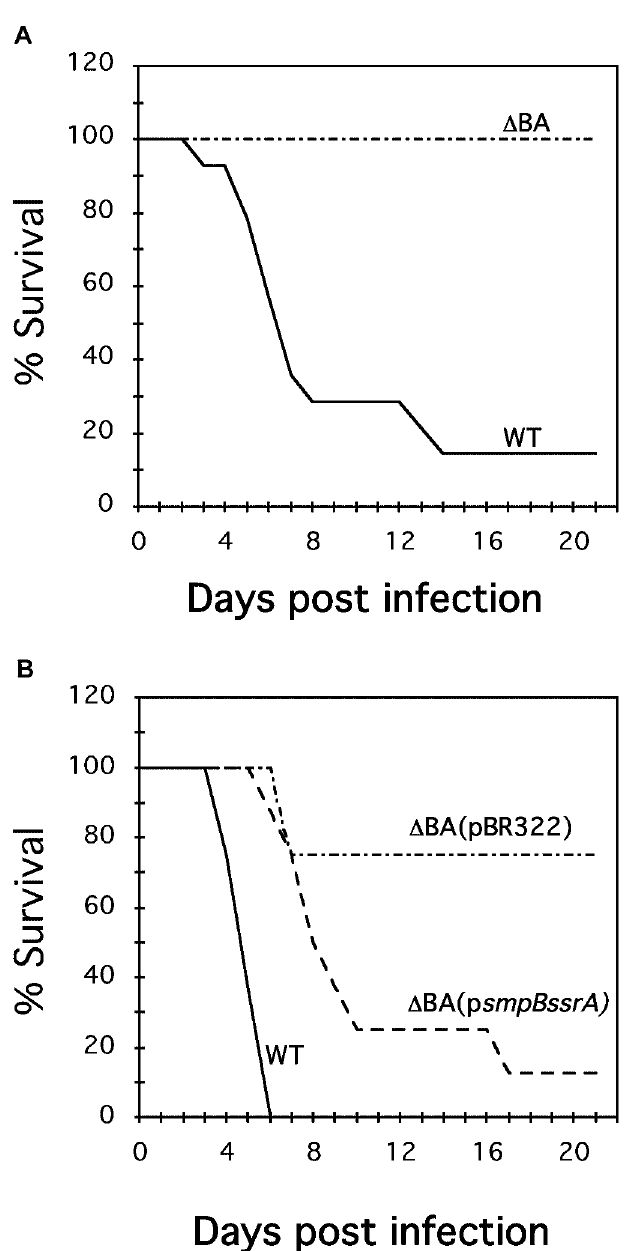
Figure 2. The smpB-ssrA Mutation Affects Survival of Mice Infected with Y. pseudotuberculosis (A) Thirty mice, in groups of five mice per strain in three independent experiments, were challenged via the orogastric route with 2 3 10 9 CFU of wild-type (WT) or D BA strain. (B) For complementation studies, a total of 16 mice, in groups of four mice per strain in two independent experiments, were infected via the orogastric route with wild-type, D BA (p smpBssrA ), or D BA (pBR322 ) strains. Mice were monitored for at least 21 d post bacterial infection. DOI: 10.1371/journal.ppat.0020006.g002